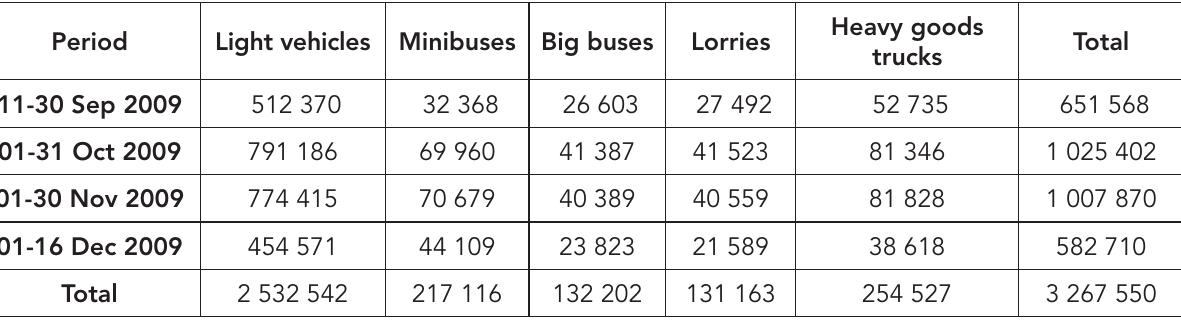
Table III: Traffic flows passing through toll